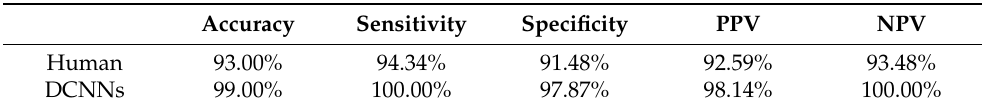
Table 3. Accuracy, sensitivity, specificity, PPV, and NPV of the recognition of low-risk high myopia (class 1).